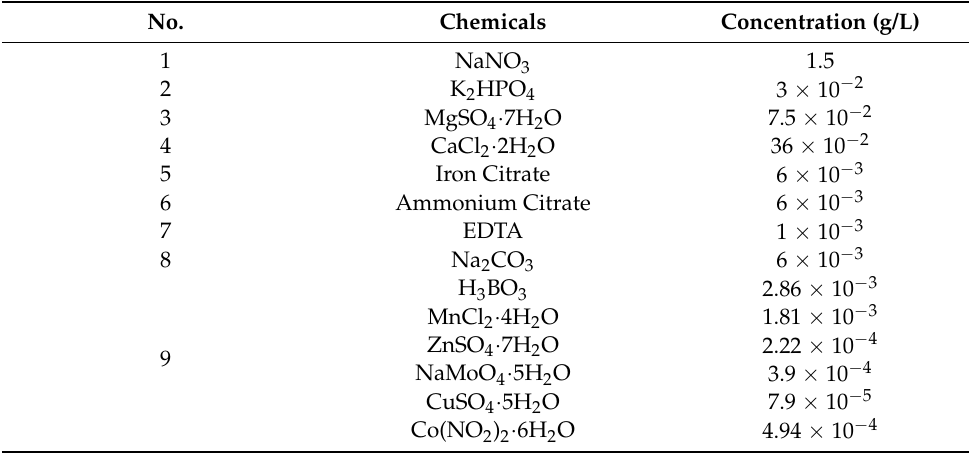
Table A1. The components of BG11